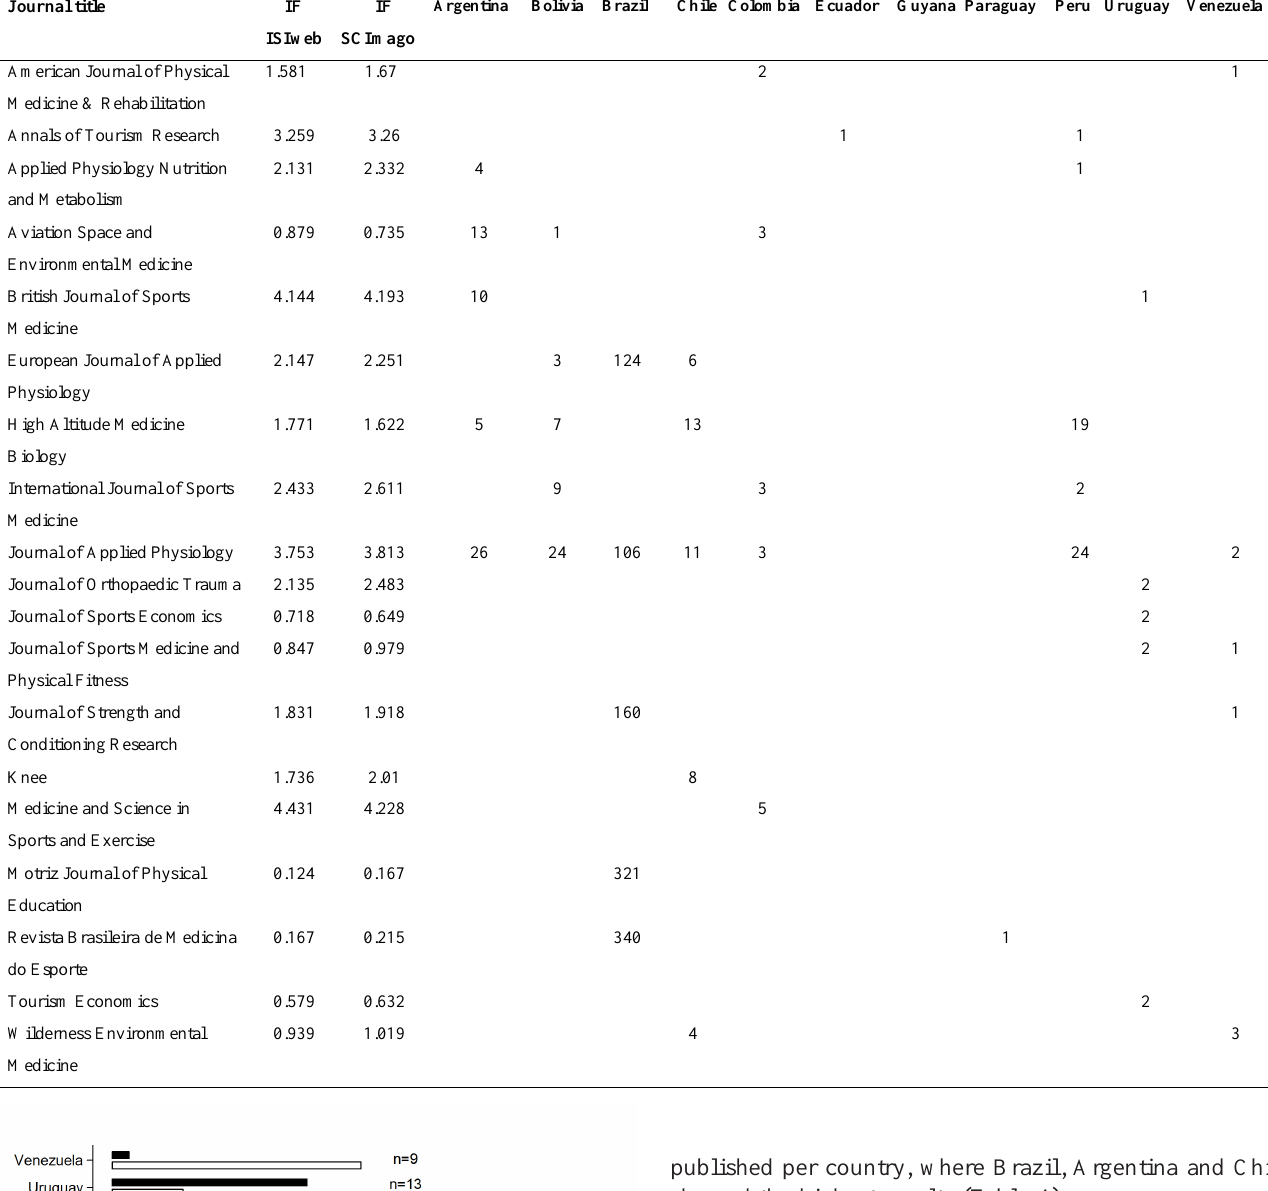
Table 3. Frequency of published articles in sports science in the most recurrent analyzed journals (based on their respective IF 2011) of South American countries.